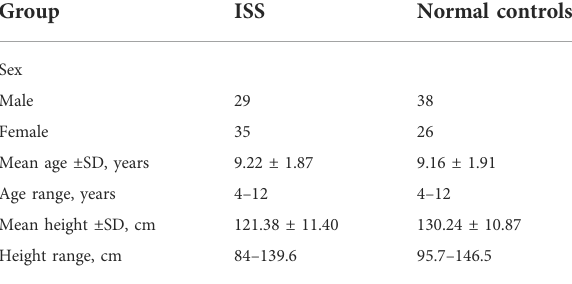
TABLE 1 The information of ISS patients and normal control individuals